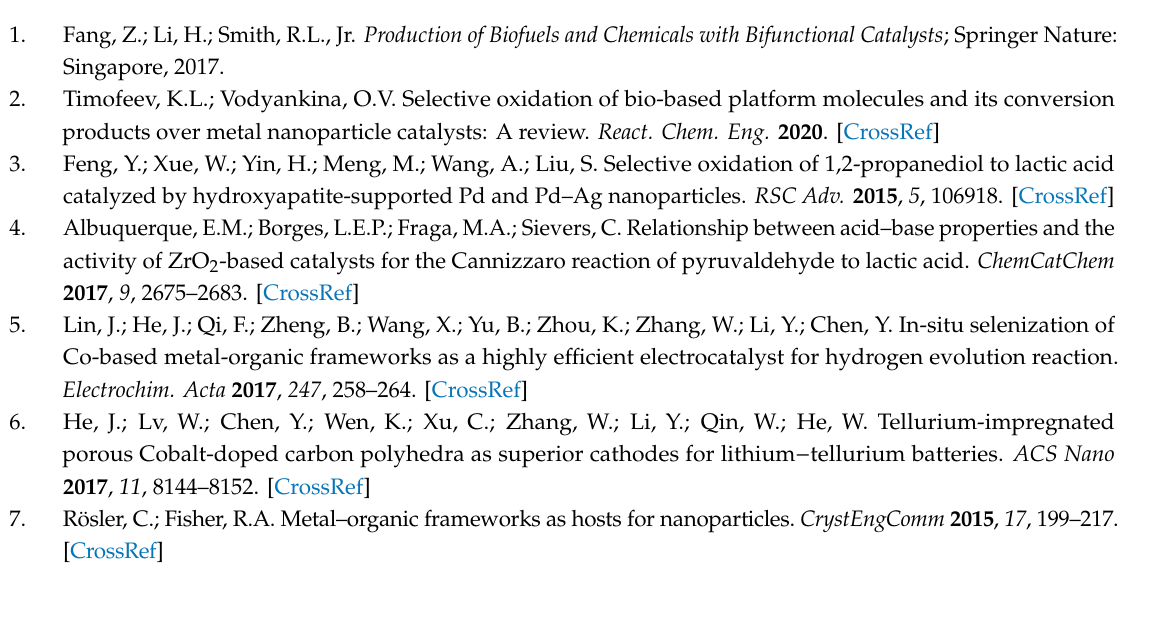
Figure S1: XRD pattern of UiO-66, Figure S2: FT-IR spectrum of UiO-66, Figure S3: TGA of as-prepared DS_N 2 H 4 1%Ag,Pd@UiO-66, Figure S4: UV-Vis DR spectra of Ag,Pd@UiO-66 prepared by using di ff erent methods, Figure S5: UV-Vis DR spectra of Ag,Pd@UiO-66 with 1%wt. (blue), 2.5%wt. (black), and 5%wt. (red) metal loading, Figure